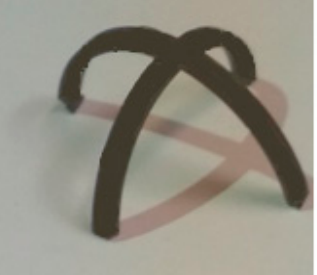
Figure 11. Deformed configuration of the flat plus-like structure after the heating–cooling process.